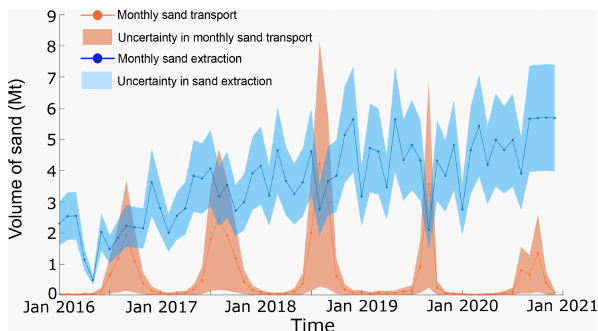
Figure 5. Monthly volumes of sand extraction (Mt) estimated from the number of vessels visible in the satellite imagery over the pe- riod 2016 to 2020 (blue) with error estimates defined by adjusting the compaction coefficient, C b , between 0.35 and 0.65 (blue shaded area). Monthly natural sand transport (Mt) at Kratie (see Sect. 2.4 for details) for the same period (orange) with error estimates de- rived by adjusting the percentage of suspended-sand fraction from 0% to 14% (around a mean of 7% – orange